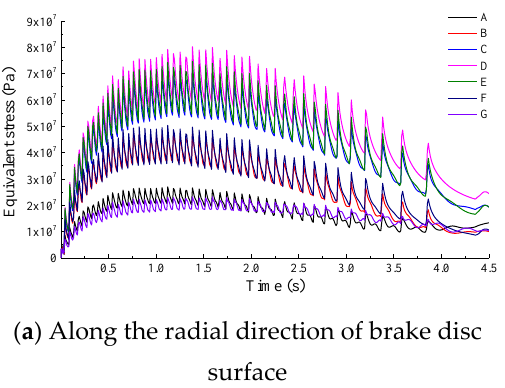
( d ) Along the axial direction at the average friction radius of brake shoe Figure 8. Temperature distributions along radial and axial paths of brake disc and brake shoe during emergency braking. 3.2.2. Equivalent Von Mises Stress Distribution